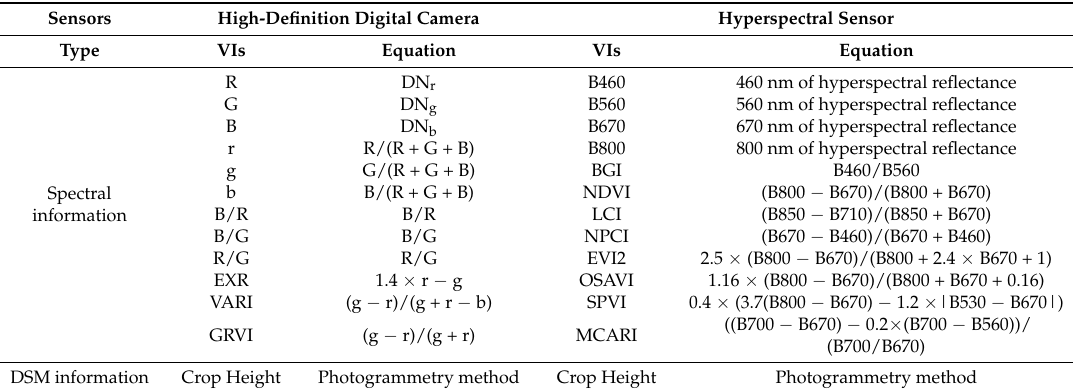
Table 2. Summary of bands and vegetation indices (VIs) used in this